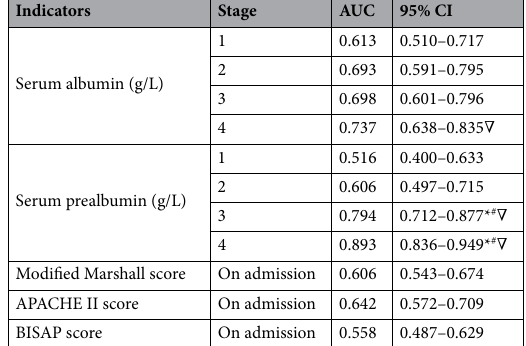
Table 7. Comparison of ROC curves for laparotomy in SAP. * P < 0.05 compared with Modified Marshall score. # P < 0.05 compared with APACHE II score. ∇ P < 0.05 compared with BISAP